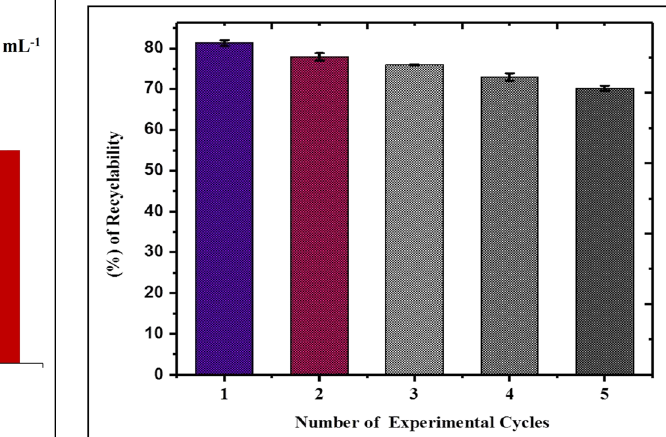
Figure 13: Recycling performance of the photo - removal of phyto - fabricated ZnO NPs from S. acuta